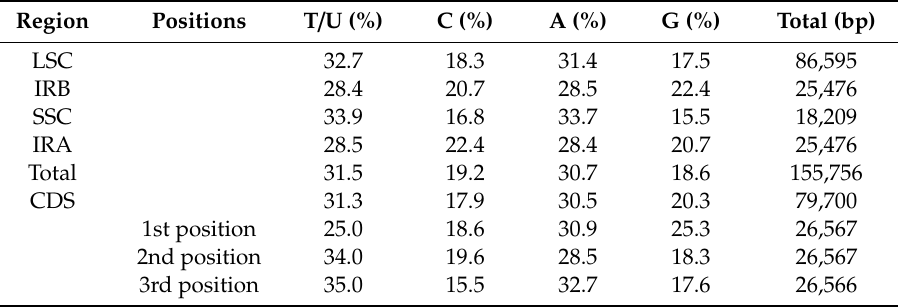
Table 1. Base composition in the chloroplast genome of L.